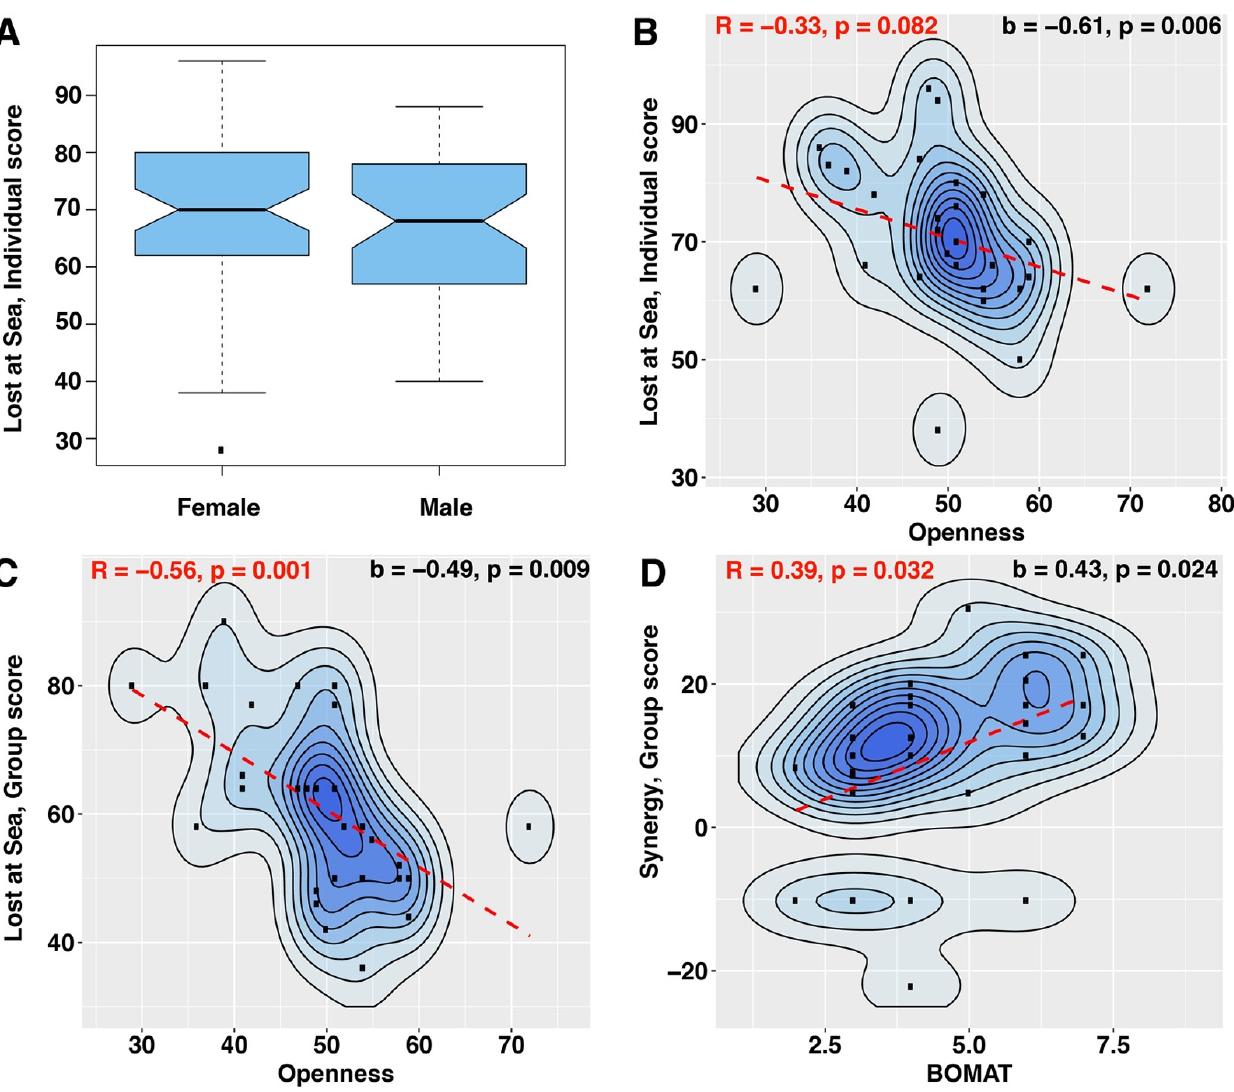
Figure 1. ( A ) Boxplot showing that the individual score for the “Lost at Sea” test is slightly lower (better) for male participants ( n = 110). ( B – D ) Scatterplots with density scales (dark blue = higher point density), Pearson correlation coefficients with corresponding p -value (red), a dotted line (red) for correlation, and the b -value and p -value from the hierarchical regression (black) ( n = 30). ( B ) The Individual score of the “Lost at Sea” test decreases (better performance) with increased openness. ( C ) The group score of “Lost at Sea” decreases (better performance) with increased openness. ( D ) The improvement in group score from the average individual score increases with an increasing BOMAT score.